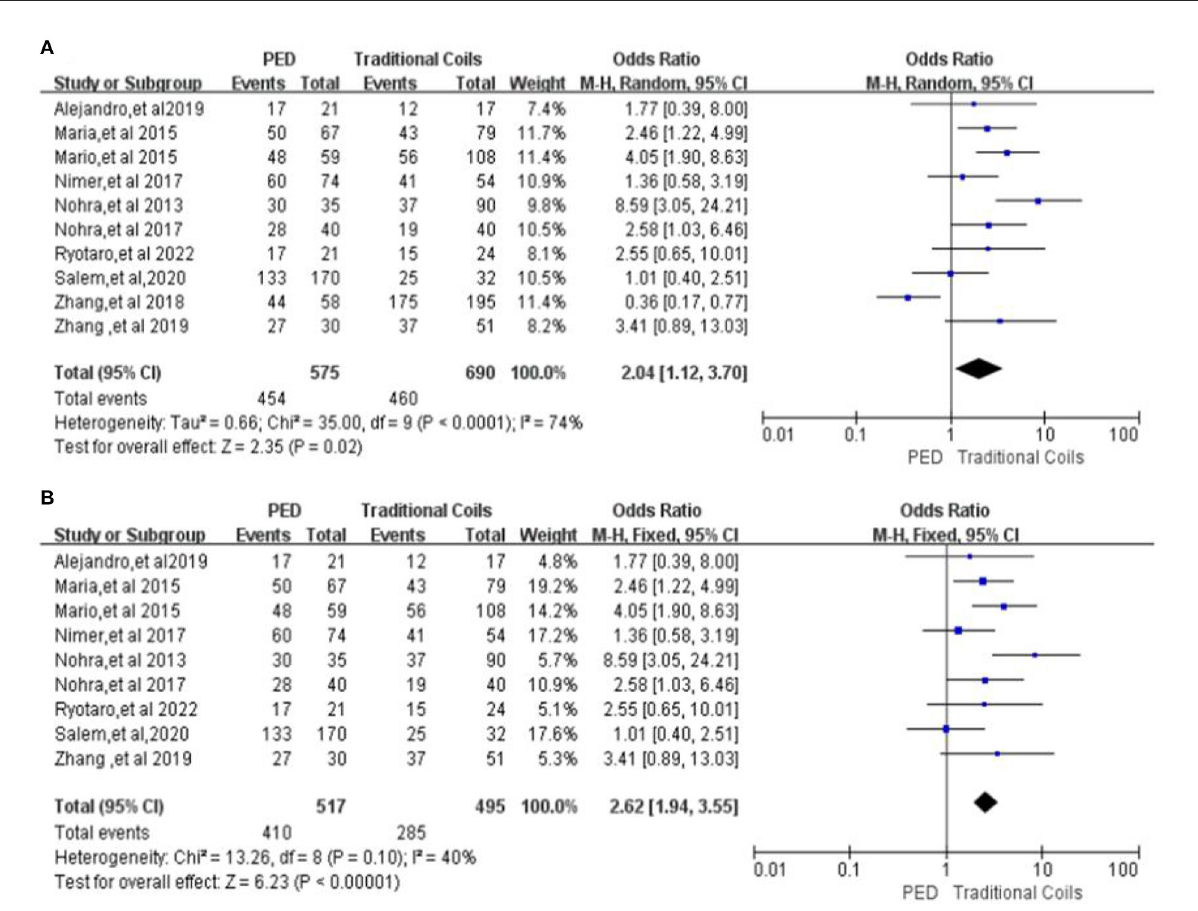
FIGURE7 (A) Forest plot and meta-analysis of complete occlusion rate (100%) of aneurysm in patients at last follow-up. (B) Forest plot and meta-analysis of Complete occlusion rate (100%) of aneurysm in patients at last follow-up after excluding the study by Zhang et al. to reduce